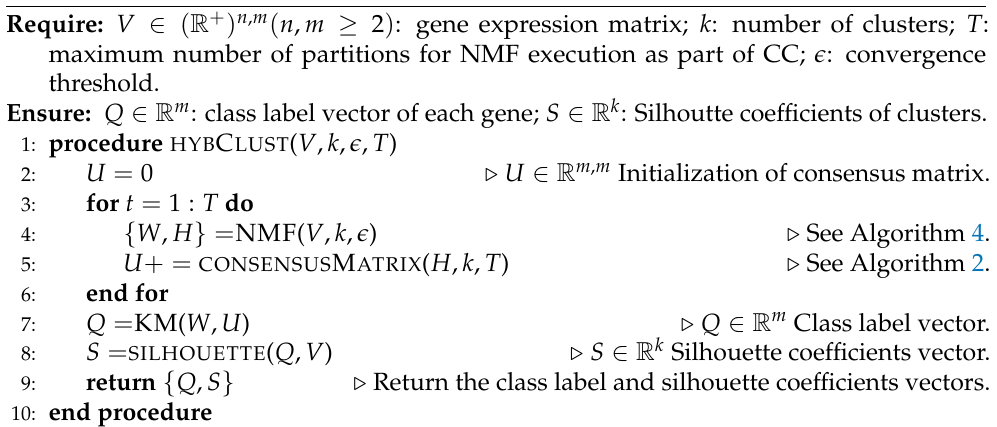
Algorithm 1 Proposal of hybrid clustering algorithm based on NMF, KM, and CC.